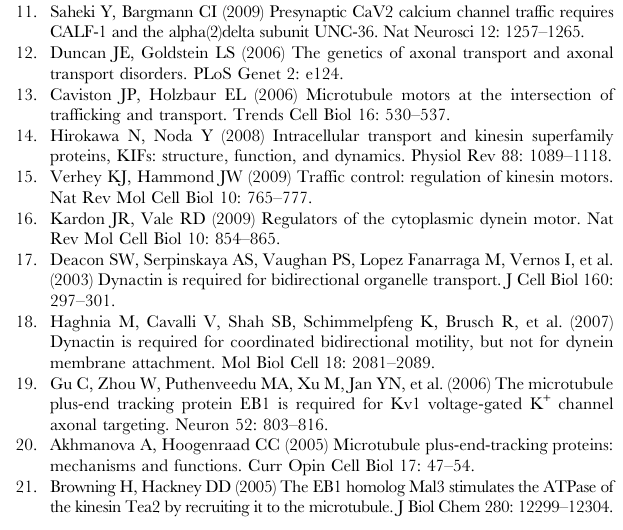
total length is 78 m m. Figure S1 Visualization and quantification of mobile puncta containing YFP-Kv1.2 in axons (A) The procedure of FRAP imaging. A neuron expressing YFP-Kv1.2 was chosen for the FRAP imaging shown by camera lucida drawing (left) with dendrites in red and the axon in blue. The YFP fluorescence in a segment of the proximal axon was first bleached with maximal excitation lights, indicated by a dashed circle (middle). Next, time- lapse imaging was performed with weak excitation lights after bleaching (right). The black cornered area is shown in Fig. 1B and the red cornered area is shown in Fig. 1C. (B) Kymographs of anterograde (left) and retrograde (right) puncta of YFP-Kv1.2 in the absence of co-expressed Kv b 2. (C) Kymographs of anterograde (left) and retrograde (right) puncta of YFP-Kv1.2 in the presence of co-expressed Kv b 2. These kymographs were generated from images captured from the proximal (within 150 m m from the soma), middle, and distal (within 150 m m from the axonal growth cone) regions of axons. (D) Measurement and calculation of the travel distance (d), the moving time (t m ), the stationary time (t s ), the velocity (v), the percentage of moving time (P moving ), and the mobile punctum frequency (F). Figure S2 Suppressing endogenous EB1 and KIF3A levels by vector-based siRNA (A) EB1 siR2 with mCherry (red) as the